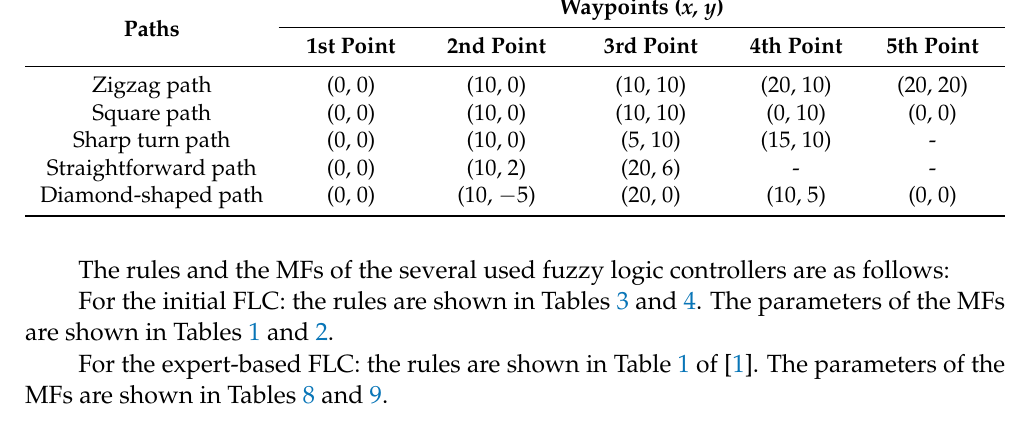
Table 8. Parameters for inputs of the expert-based